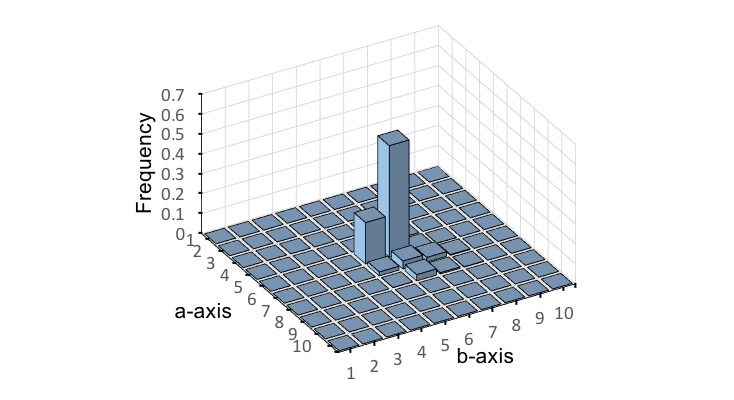
Figure 5. Mean color histogram for H and G .